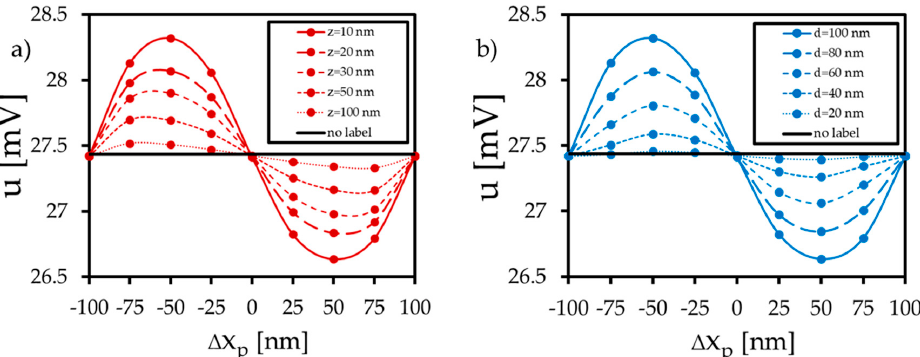
Figure 8. Simulated electric potential u of the GMR element due to the x-shift in the magnetized label. ( a ) Electric potential due to different label heights ∆ z (d = 100 nm). ( b ) Electric potential due to different label diameters d ( ∆ z = 10 nm).